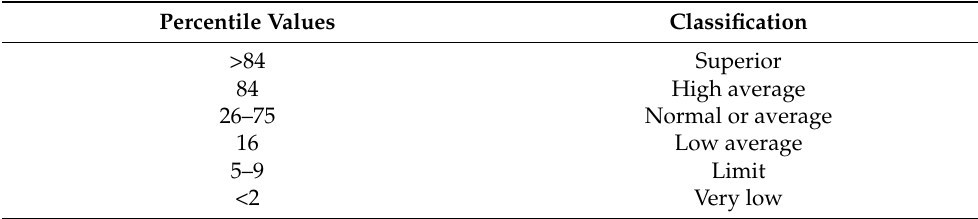
Table 1. Range and rankings of percentile values for defining the children’s